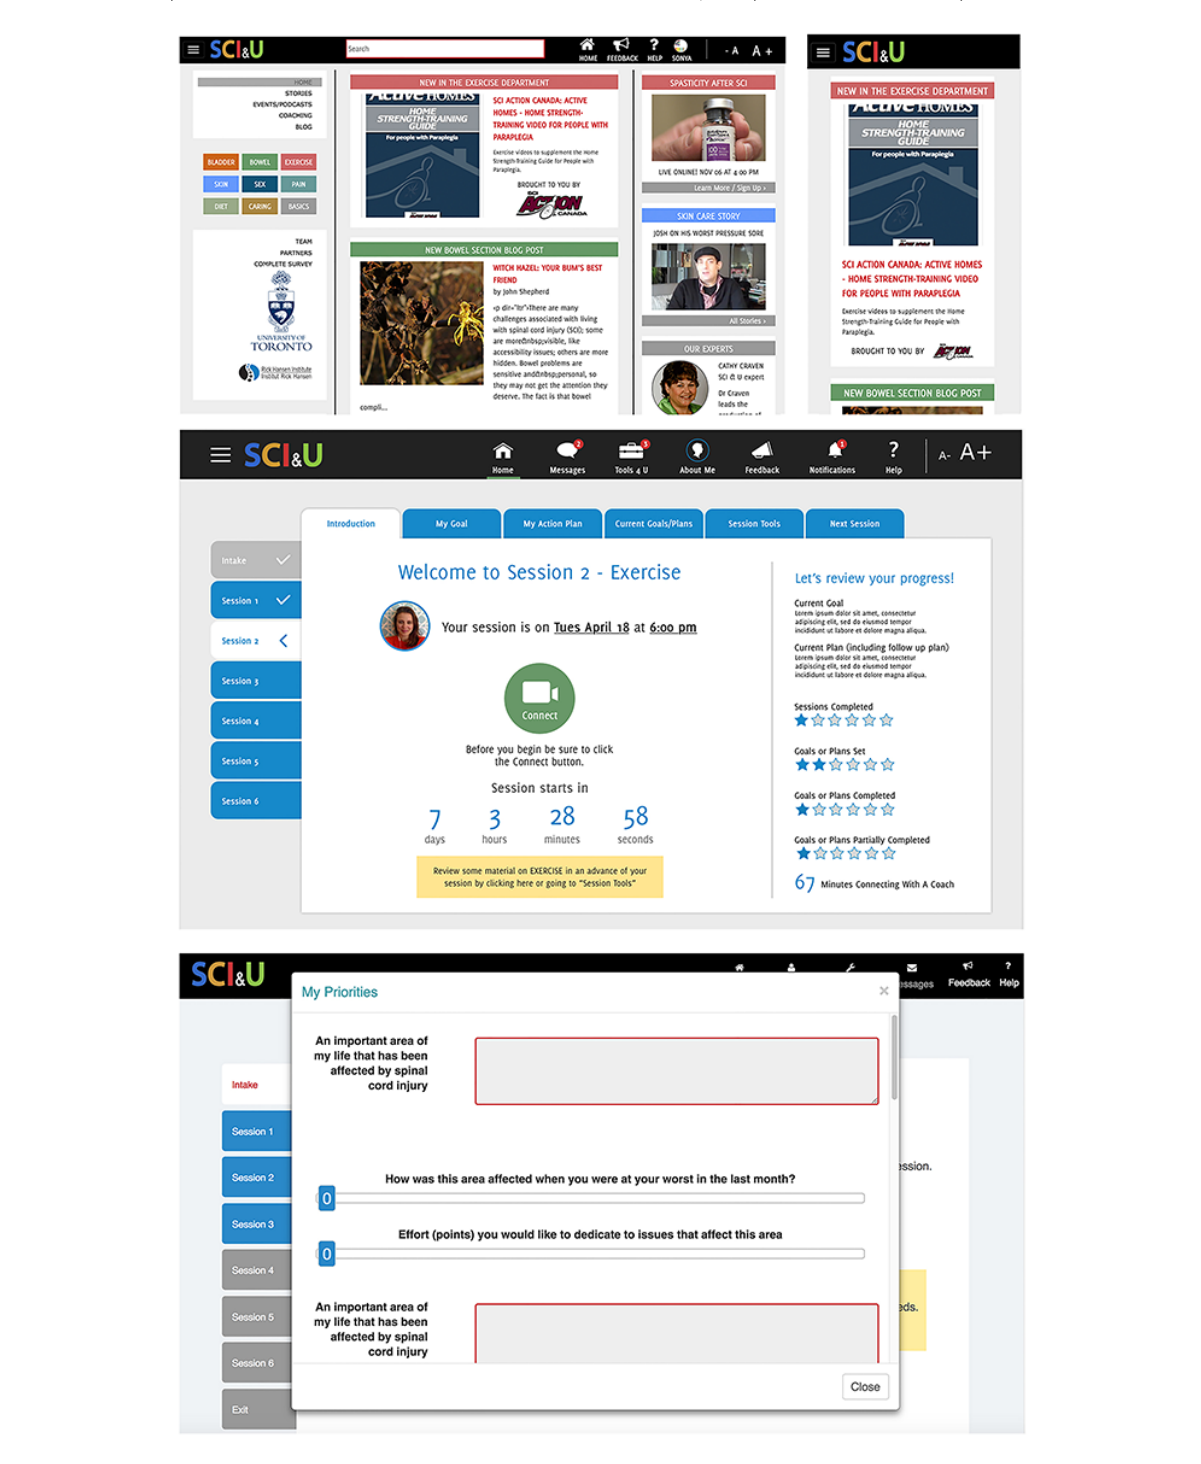
Figure 1. Top: the publicly accessible informational website that was designed to support the SCI & U program. In the middle, designs for the coaching dashboard of the secure platform. Bottom: a customized Patient Generated Index form, as implemented in the secure